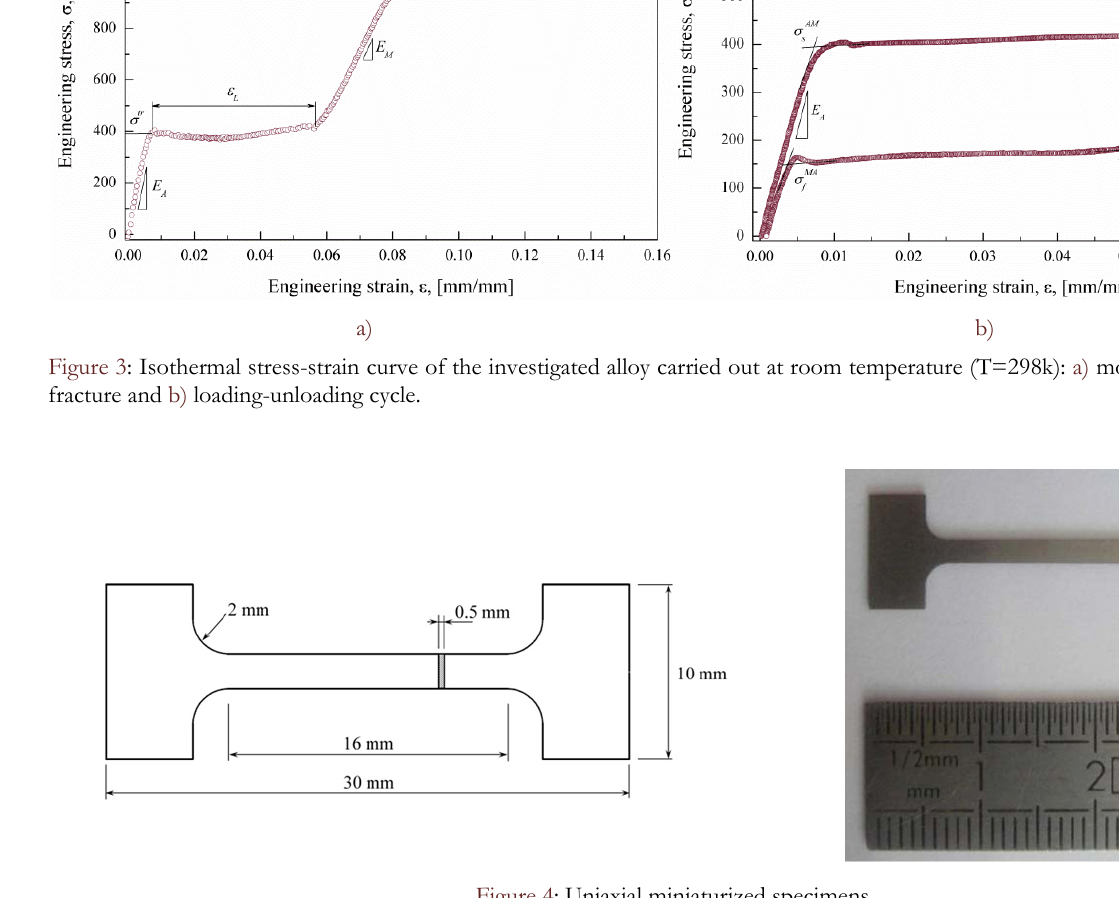
Figure 4: Uniaxial miniaturized